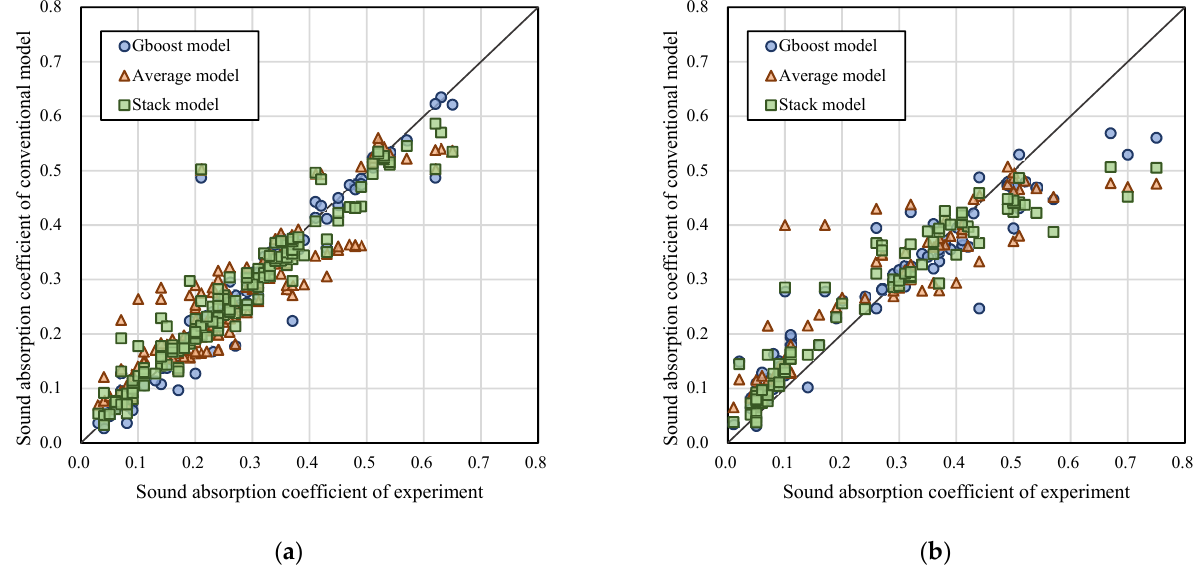
Figure 11. Scatter plot of machine learning models: ( a ) training set; ( b ) testing set.